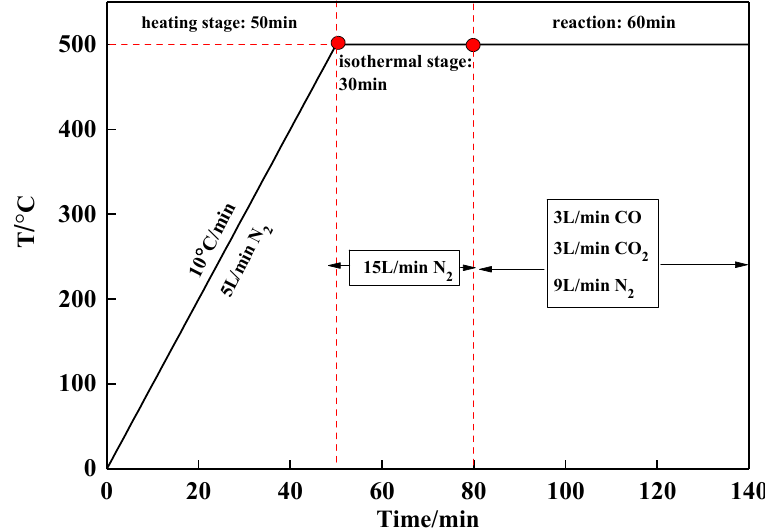
Figure 4. Schematic diagram of reduction disintegration equipment.